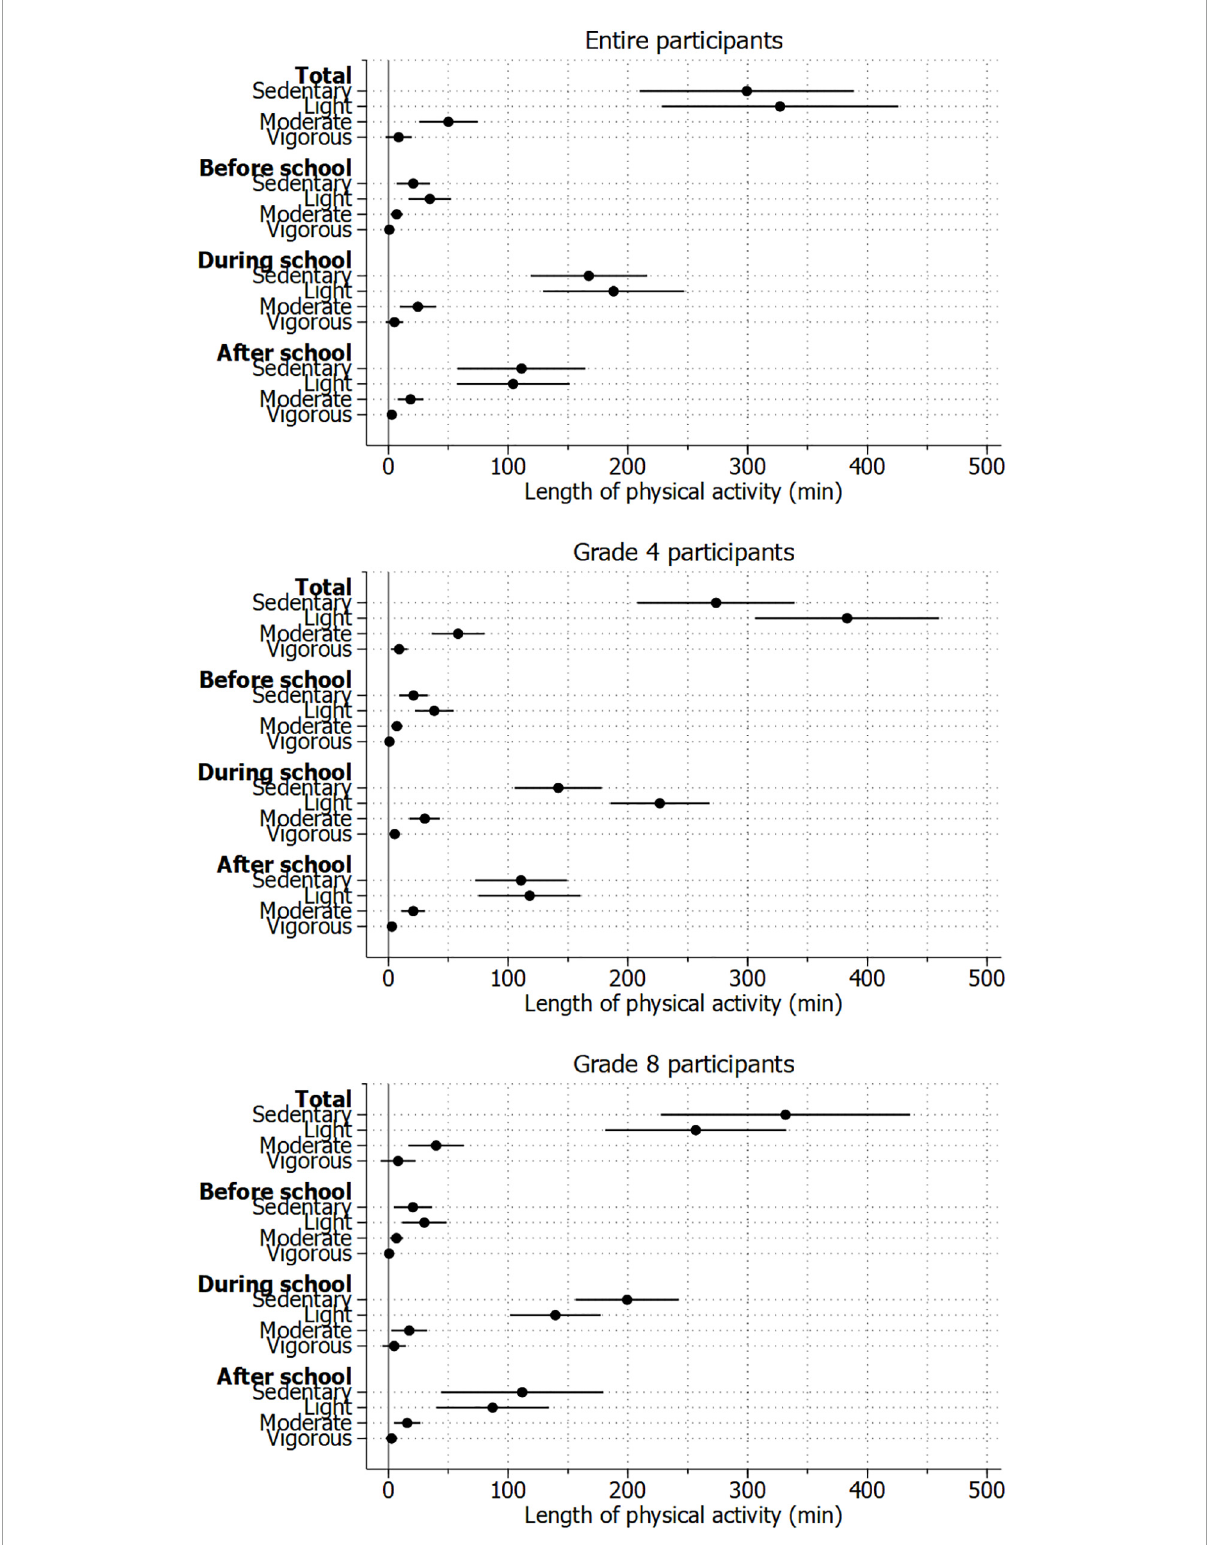
FIGURE2 Length of physical activity in a week among the study